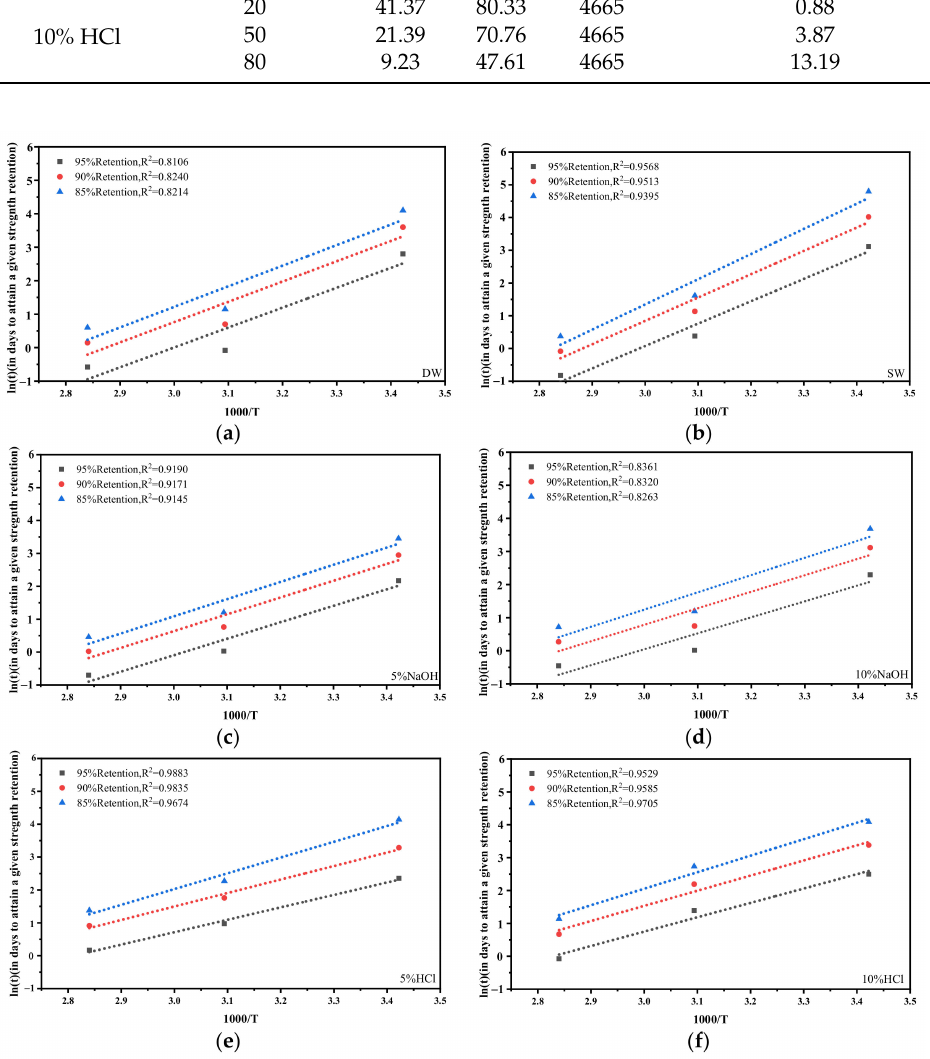
Figure 14. Arrhenius plots: specimens exposed to ( a ) DW, ( b ) SW, ( c ) 5% NaOH, ( d ) 10% NaOH, ( e ) 5% HCl, and ( f ) 10%